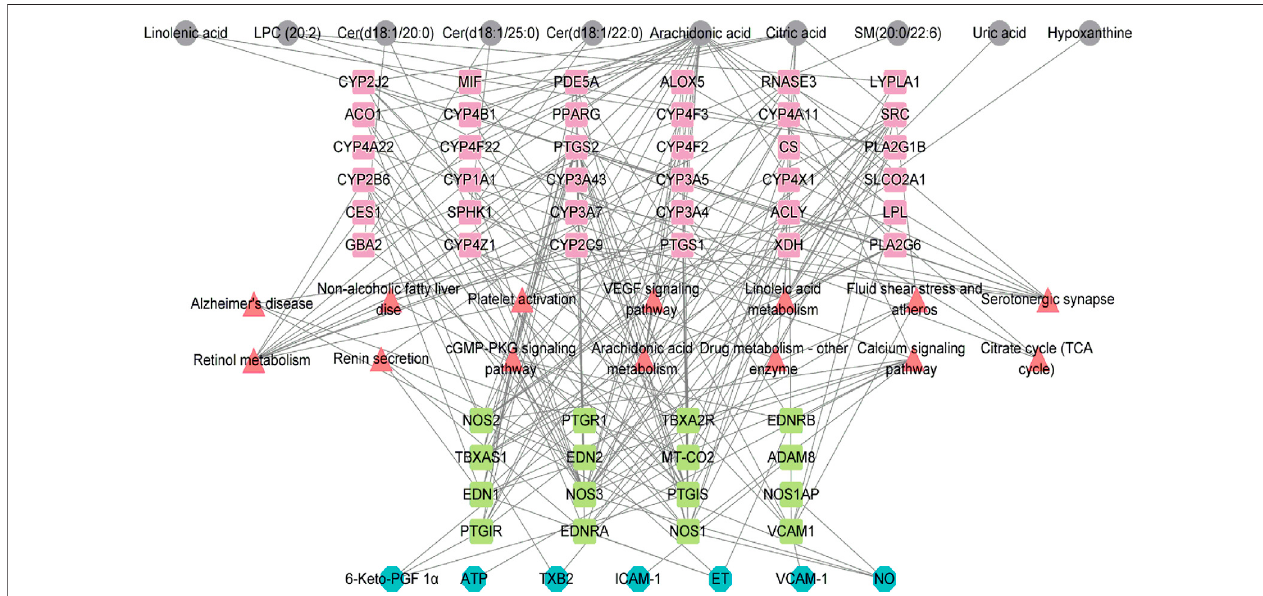
FIGURE 5 | Network showing the interactions among indexes related to vascular endothelial damage, ATP, protein targets, metabolic pathways that arc signi fi cantly altcrcd in CHD, and the identi fi ed metabolites. Grey nodes represent the identi fi ed metabolites; red nodes represent pathways related to these metabolites; pink and grccn nodes represent the identi fi ed protein targets; bluc nodes rcprcscnt thc relatcd indcxcs of vascular cndothclial damagc and ATP.